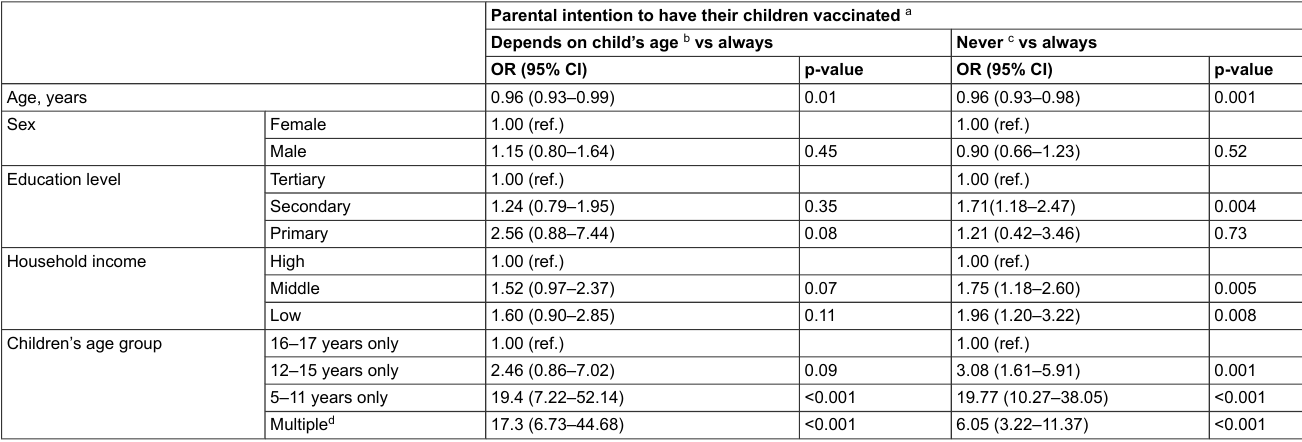
Table 2. : Association between sociodemographic factors and parental intention to vaccinate children. Estimates (odds ratio and 95% confidence interval) are from multinomial logistic regression, mutually adjusted for all variables presented in this table. Reference categories are female sex, tertiary educational level, high household income, and having children in only the 16–17 years age group. The analytical sample for complete case multinomial mod- el was n =